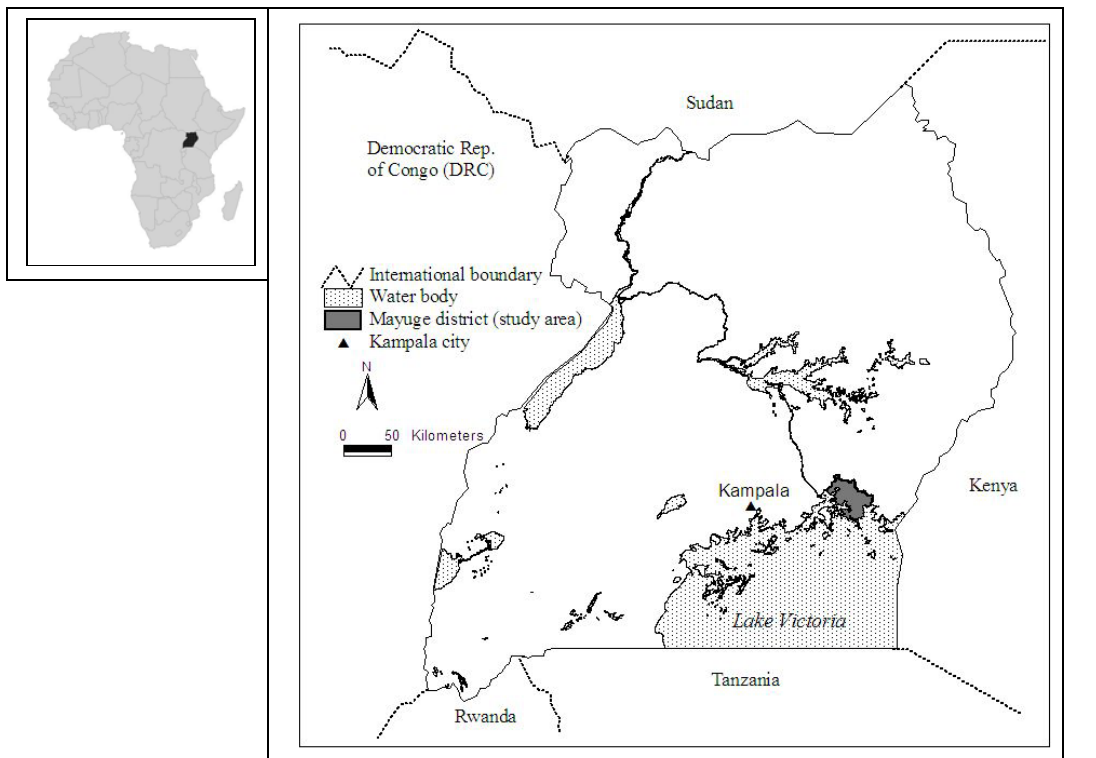
Figure 2. Map of Uganda showing the Mayuge district (study